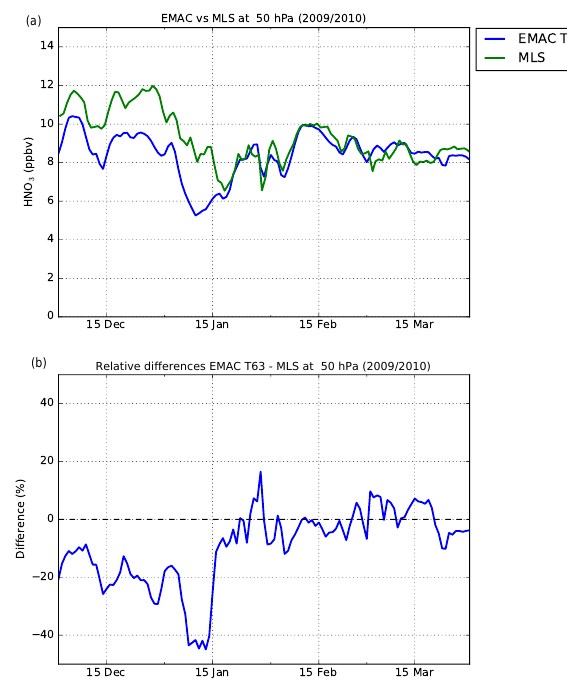
Figure 6. (a) Time series of HNO 3 (at 50hPa) from EMAC (blue) and Aura/MLS (green) for the Arctic winter 2009/2010 (1 Decem- ber 2009 to 31 March 2010, 70–90 ◦ N). (b) Relative differences of the EMAC–MLS time